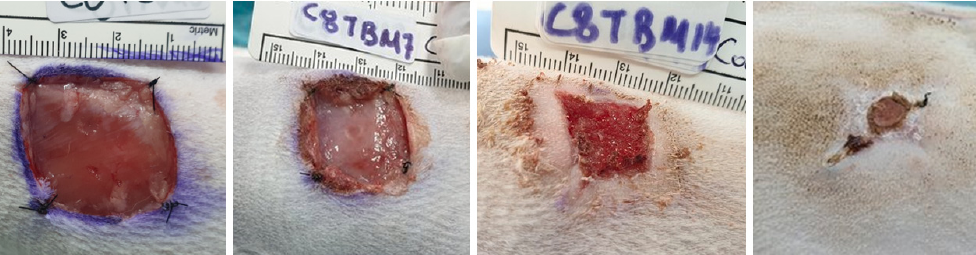
Figure 3. Control wounds during different measurement times (days 0, 7, 14, 25).